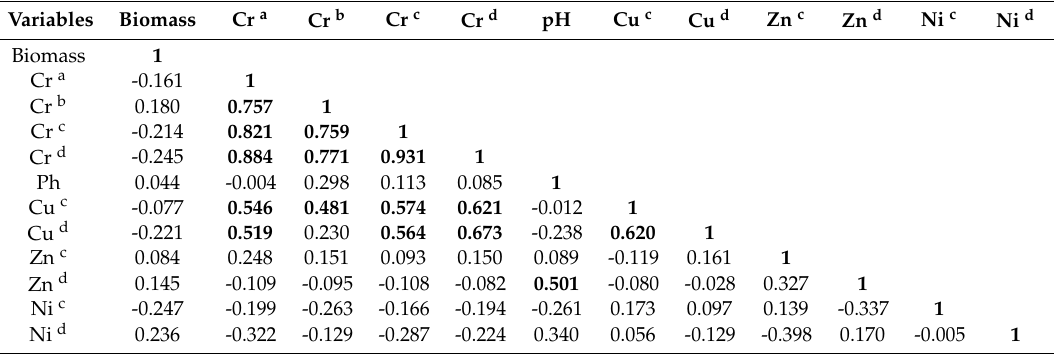
Table 4. Correlation matrix between physico-chemical properties of soil and plant-related parameters. Variables Biomass